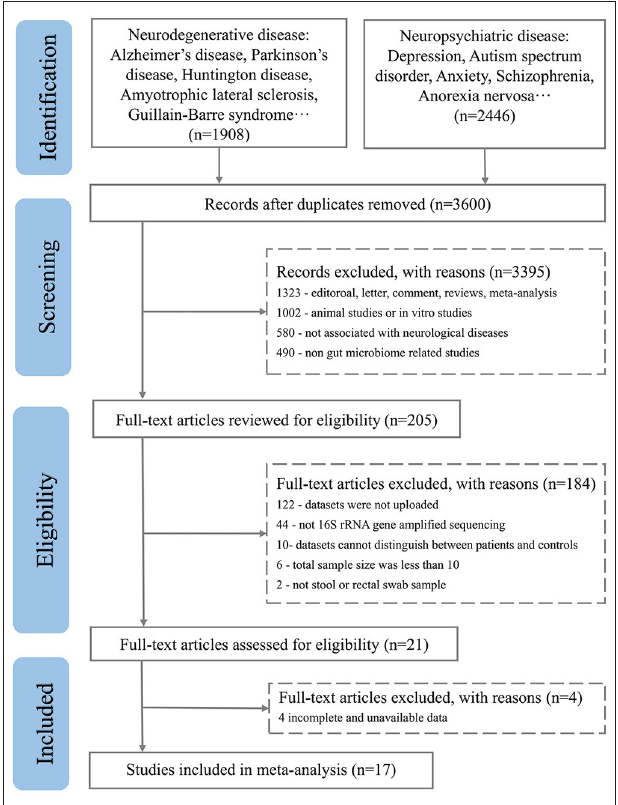
FIGURE 1 | PRISMA flow diagram depicting the screening process from the Pubmed database for inclusion of